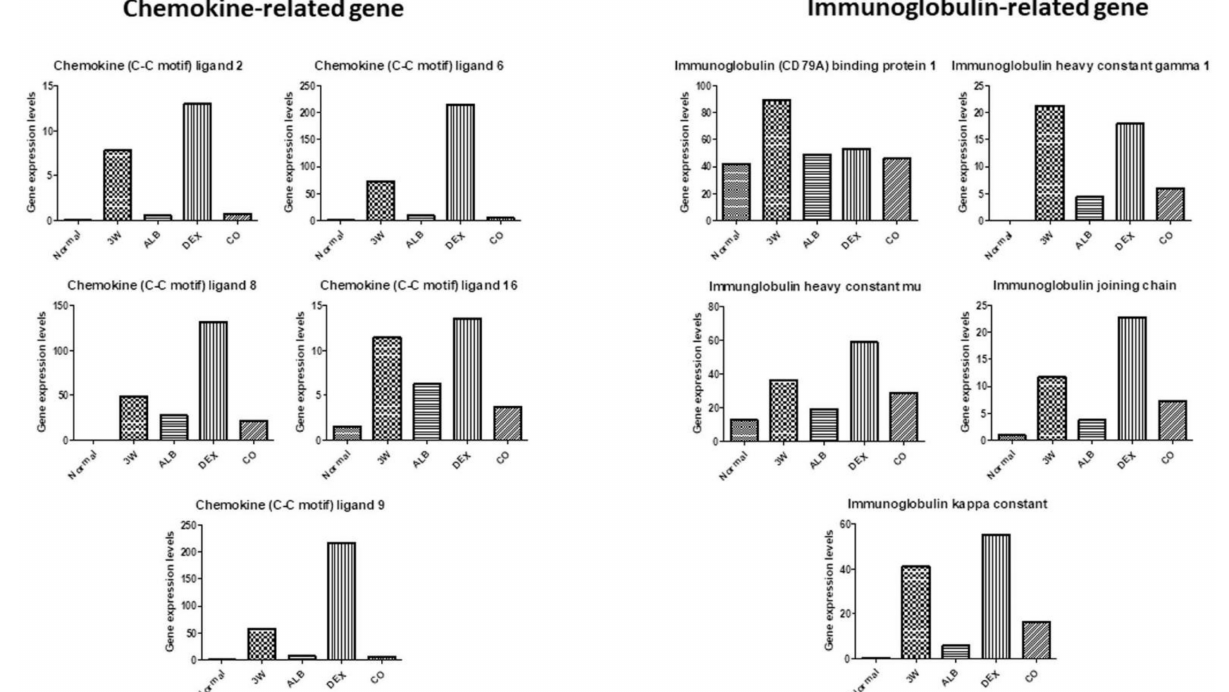
Figure 14. RNA-seq data of chemokine-related and immunoglobulin-related genes after treatment of albendazole alone dexamethasone alone, and co-therapy of the two drugs to BALB/c mice infected with Angiostrongylus cantonensis